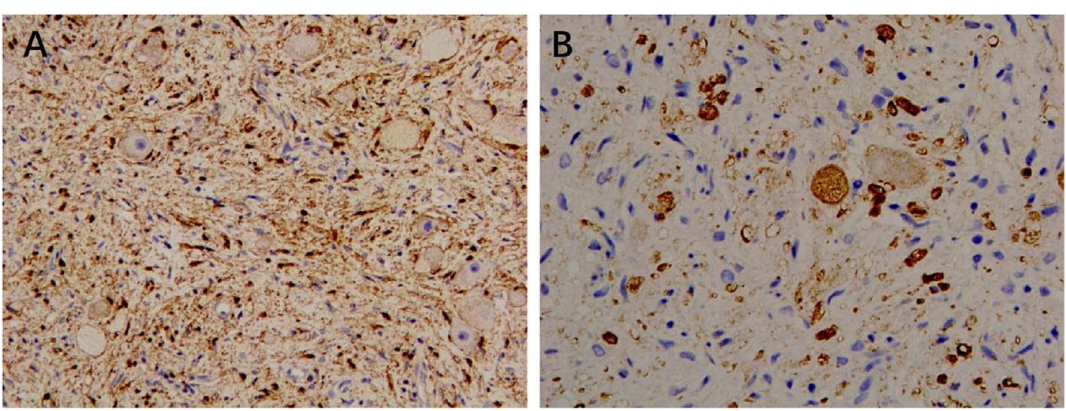
Fig. 4 Immunohistochemical staining showed positive Schwann cell interstitial S-100 ( A ) and ganglion cells were NSE positive ( B ). Original magnification ×